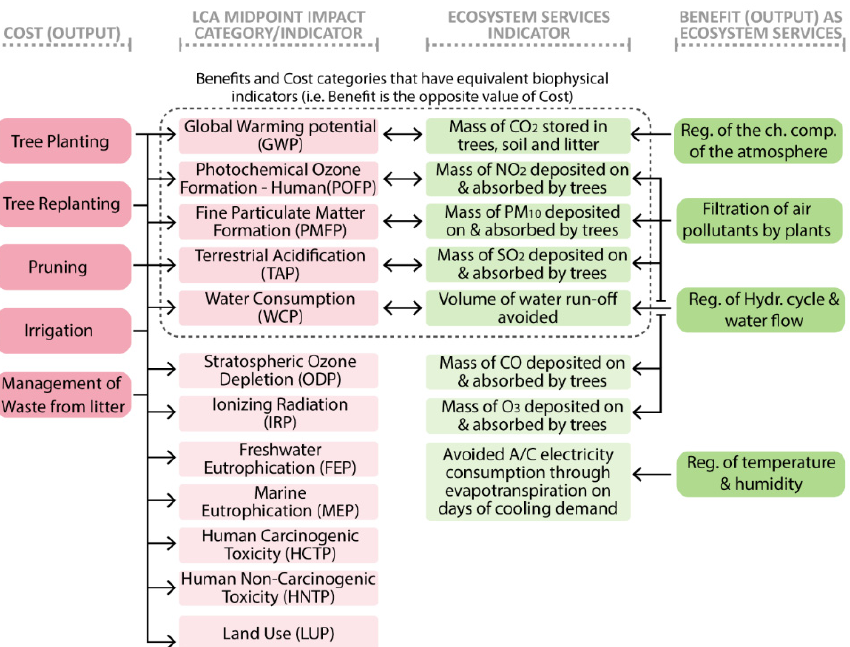
Figure 3. Biophysical indicators that represent cost and benefits in the form of negative and positive environmental impacts. The cost and benefits with equivalent indicators are highlighted. All the costs (outputs) contribute to environmental impacts represented by life cycle assessment (LCA) midpoint impact